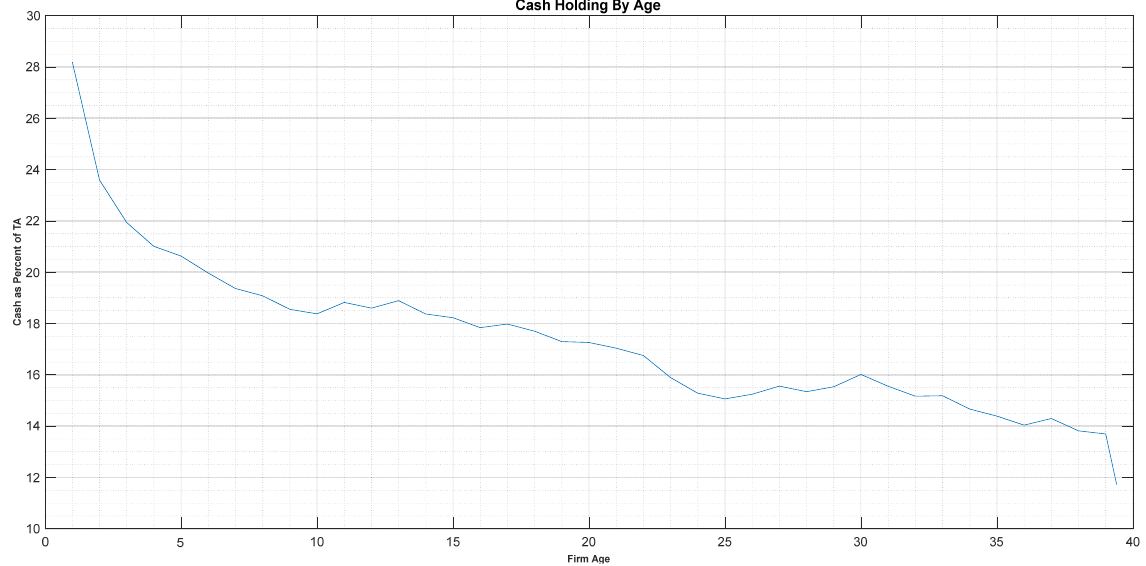
Figure 2. Average cash ratio by age. The line represents the cross-sectional annual average cash and short-term investment to total assets ratios based on firms’ age. We consider a firm’s age firstly when it appears in the yearly Compustat data the first time, secondly in the subsequent year, and so on. Firms’ ages are truncated at 40. For each age group, we find the cross-sectional average cash and short-term investment to total assets ratios and plot them against age.